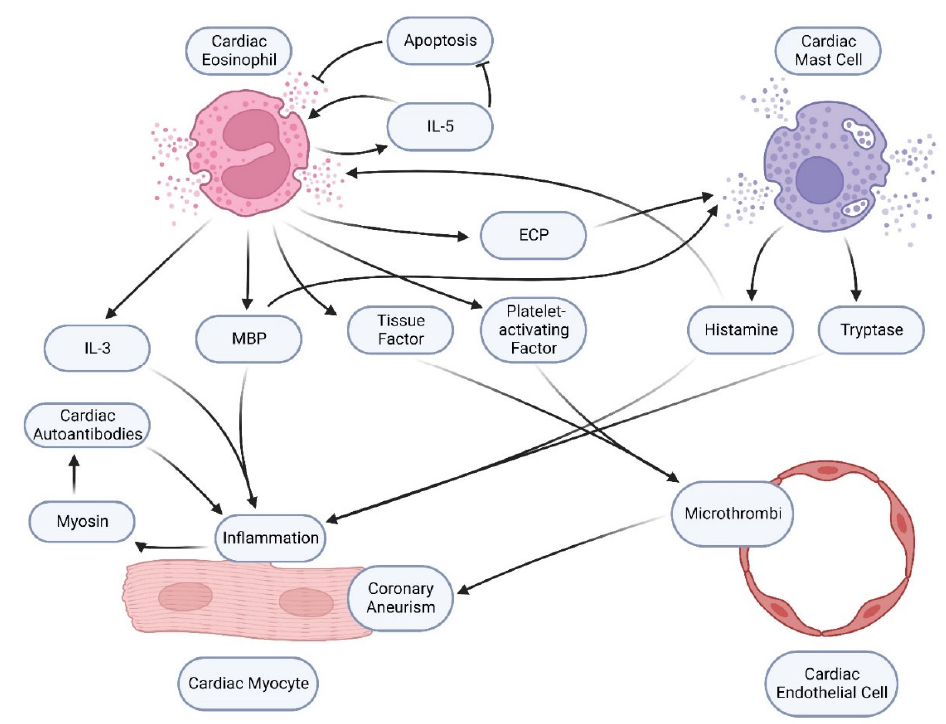
Figure 3. Cardiac damage pathways from eosinophilic myocarditis. Cardiac eosinophil degranulation causes direct damage to cardiac myocytes through the release of interleukin-3 (IL-3) and major basic protein (MBP), causing inflammation. Interleukin-5 (IL-5) is released and recruits more eosinophils and inhibits apoptotic pathways, increasing the total eosinophil load locally in the cardiac tissue. The MBP, along with eosinophil cationic protein (ECP), also causes degranulation of cardiac mast cells. This releases histamine and tryptase, additional mediators of myocyte inflammation. Histamine has the secondary function of recruiting additional eosinophils to the area. Tissue factor and platelet‐activating factor release from eosinophil degranulation, leading to platelet aggregation and microthrombi in cardiac endothelial cells, causing indirect damage to cardiac myocytes and increasing the risk for coronary aneurisms. Inflammation and injury to cardiac myocytes releases intracellular myosin which can be recognized by the immune system which develops myosin auto‐antibodies, compounding myocyte inflammation and injury. Figure created with BioRender.